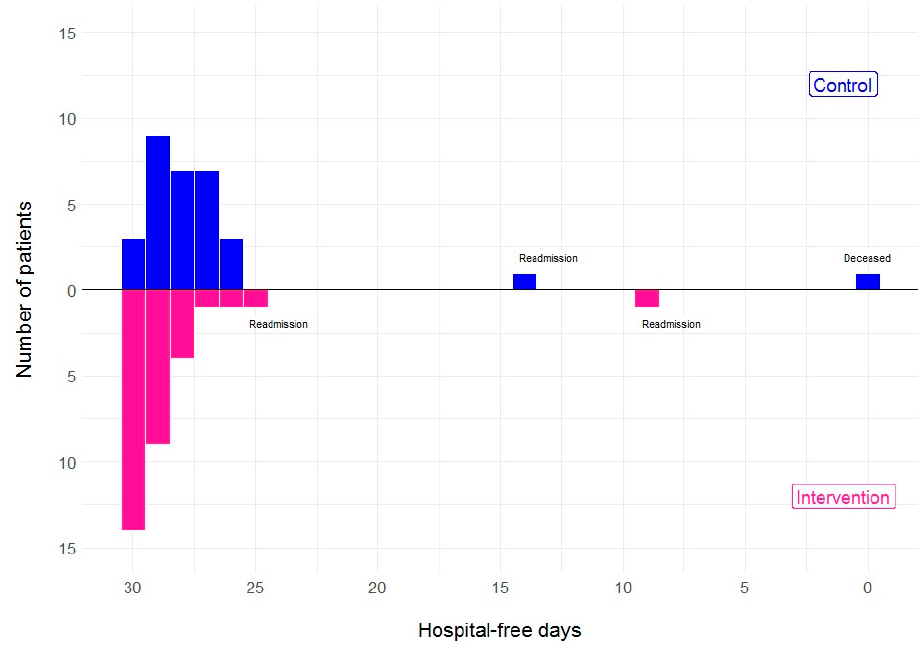
Figure 2. Distribution of number of hospital-free days 30 days after randomisation.